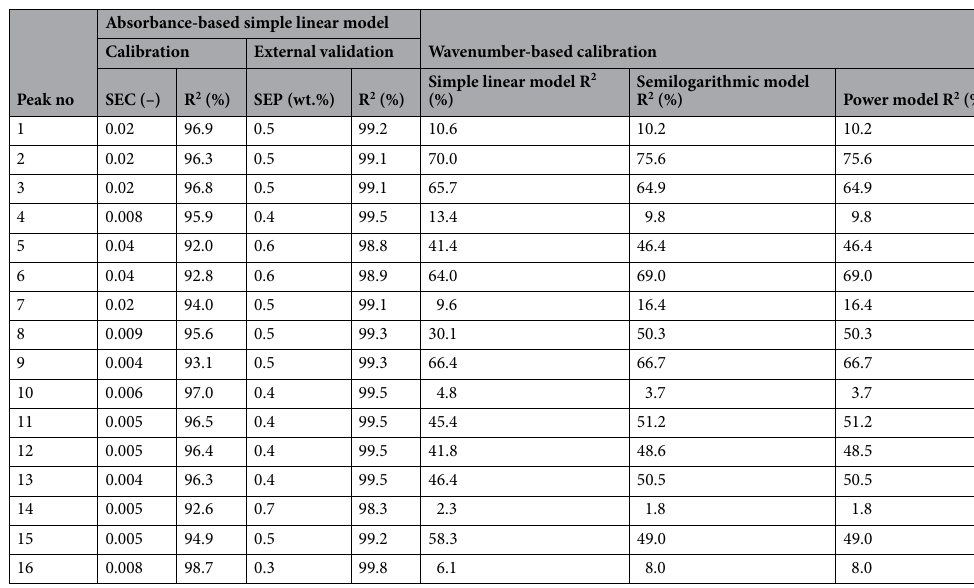
Table 2. Quality parameters for models’ calibration and external set validation for the models selected (p-value for each regression on the level < 0.5). SEC standard error of calibration, SEP standard error of prediction, R 2 adjusted coefficient of